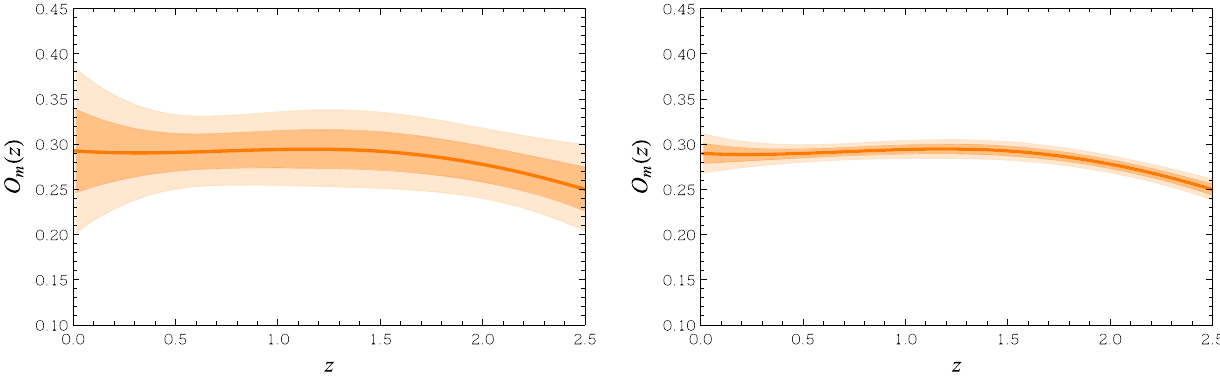
Fig. 4 O m ( z ) vs z with 1 σ and 2 σ CL regions, reconstructed from SN+BAO+CC data (left panel) and SN+BAO+CC+H0LiCOW data (right